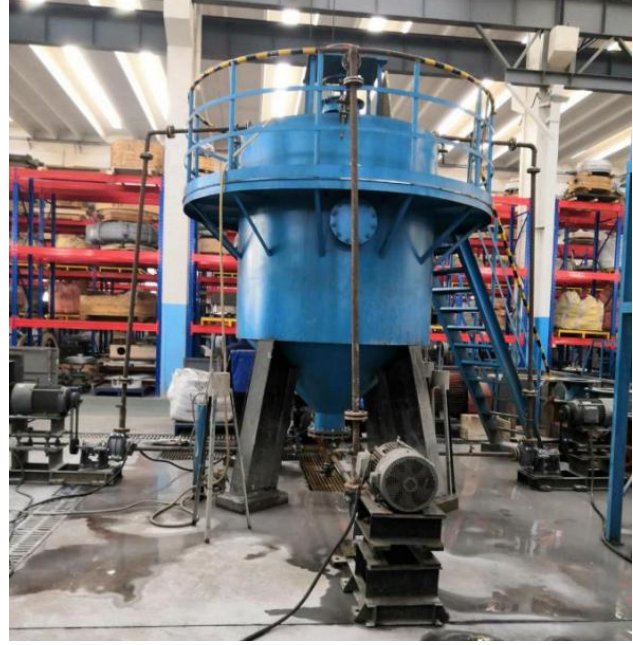
Figure 19. Wear test